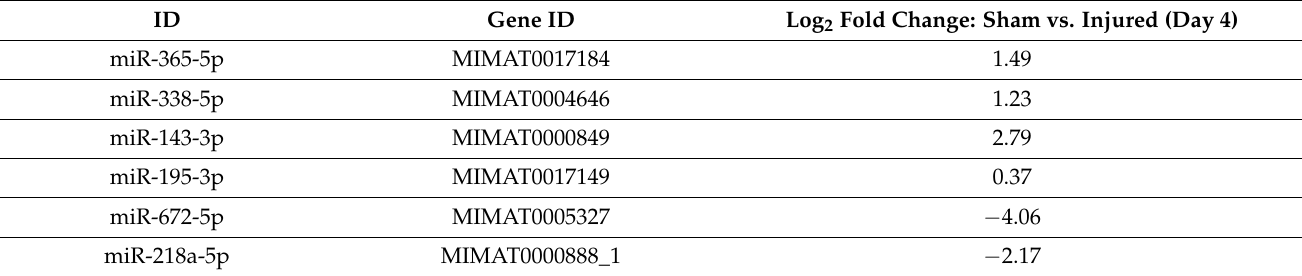
Table 2. qRT-PCR validation of serum miRNAs differentially expressed between sham and injured tendons at day